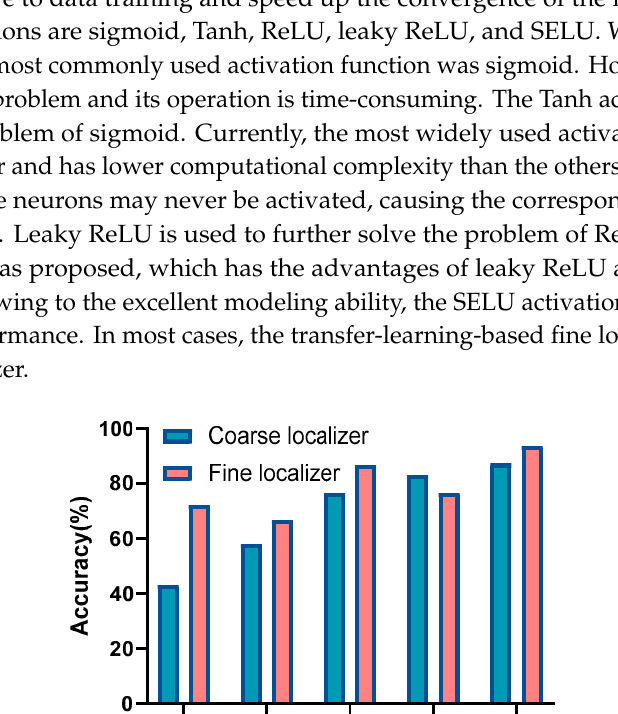
Figure 13. Positioning performance with different activation functions.